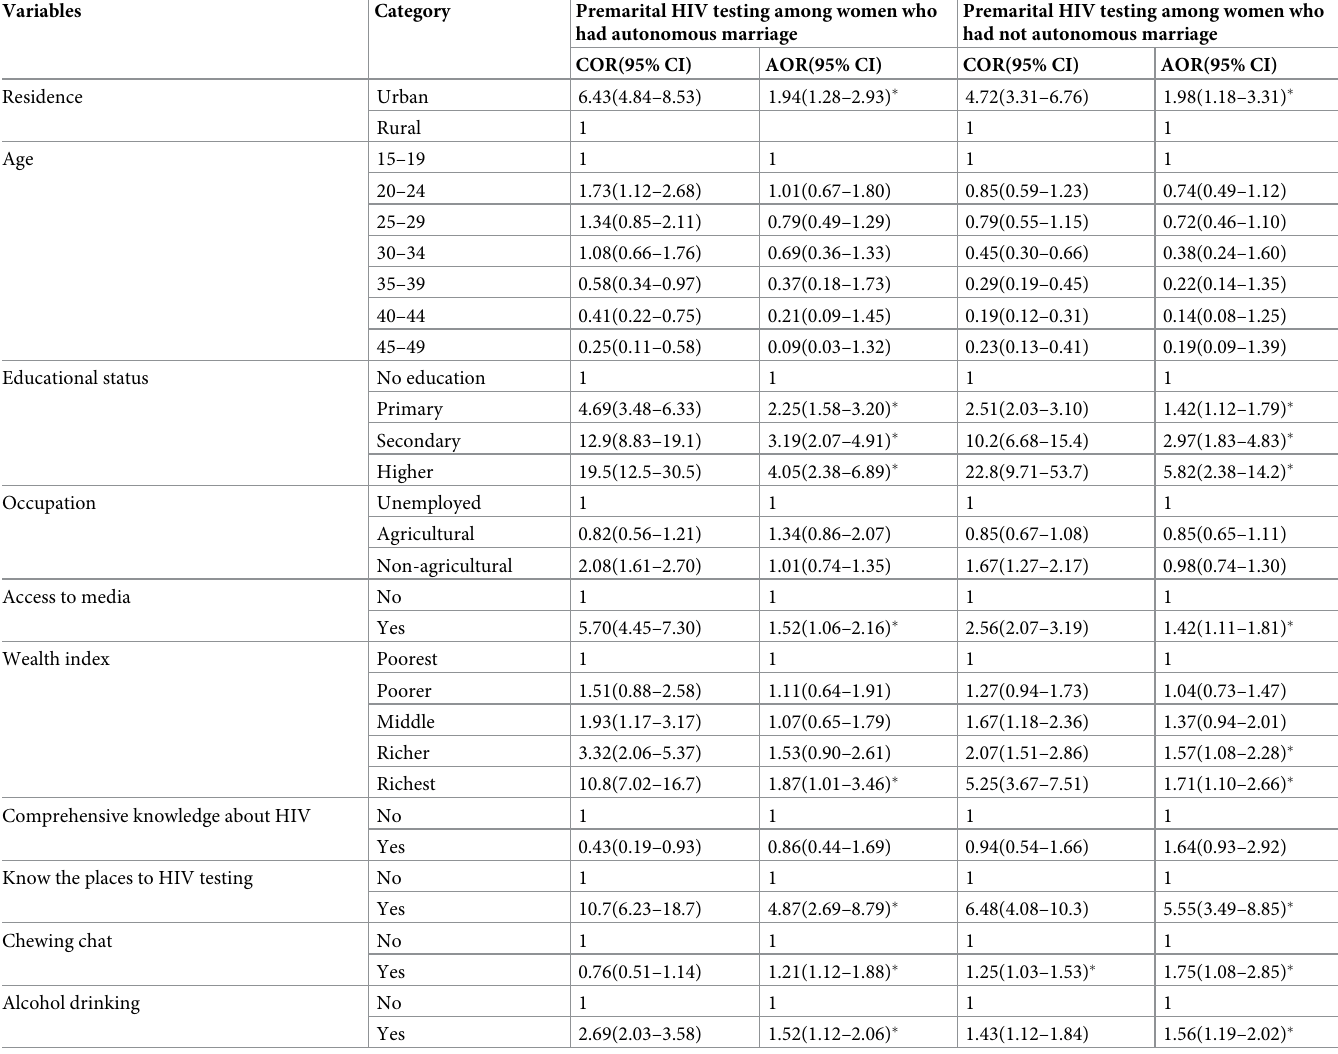
Table 3. Multivariable analysis table for identifying factors of premarital HIV testing among women who had autonomous (n = 4043) versus non autonomous (n = 5559) marriage in